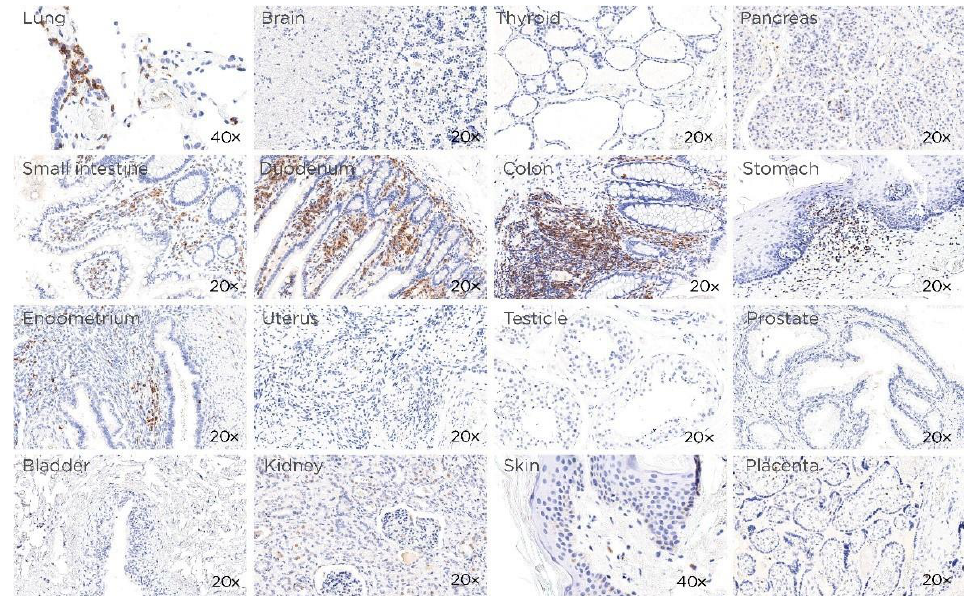
Figure 4 Figure 3. Expression of CD229 in normal tissues. Single immunoperoxidase labeling in reactive human tissues with mAb (clone PIZCU426) against CD229 (magnification: 20 × images, brain, thyroid pancreas, small intestine, duodenum, colon, stomach, endometrium, uterus, testicle, prostate, bladder, kidney, skin, placenta and 40 × lung and skin).